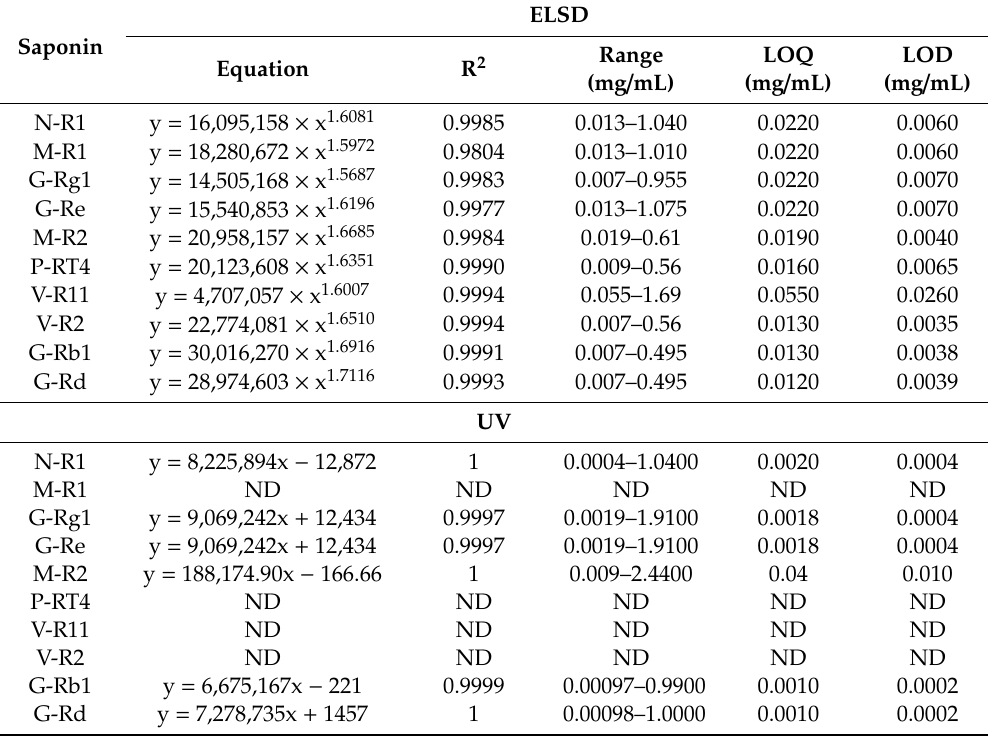
Table 1. Calibration curve for ten saponins in the ELSD and UV detectors.